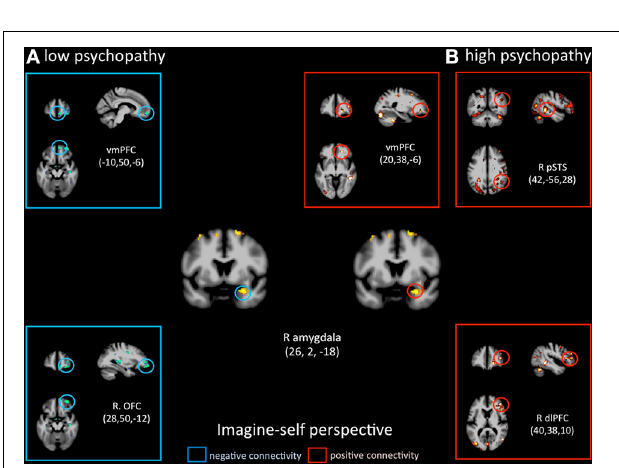
FIGURE 7 | Functional connectivity analyses, seeded in the right amygdala in participants with the lowest scores on the PCL-R and participants with the highest scores on the PCL-R ( > 30) during imagine-other